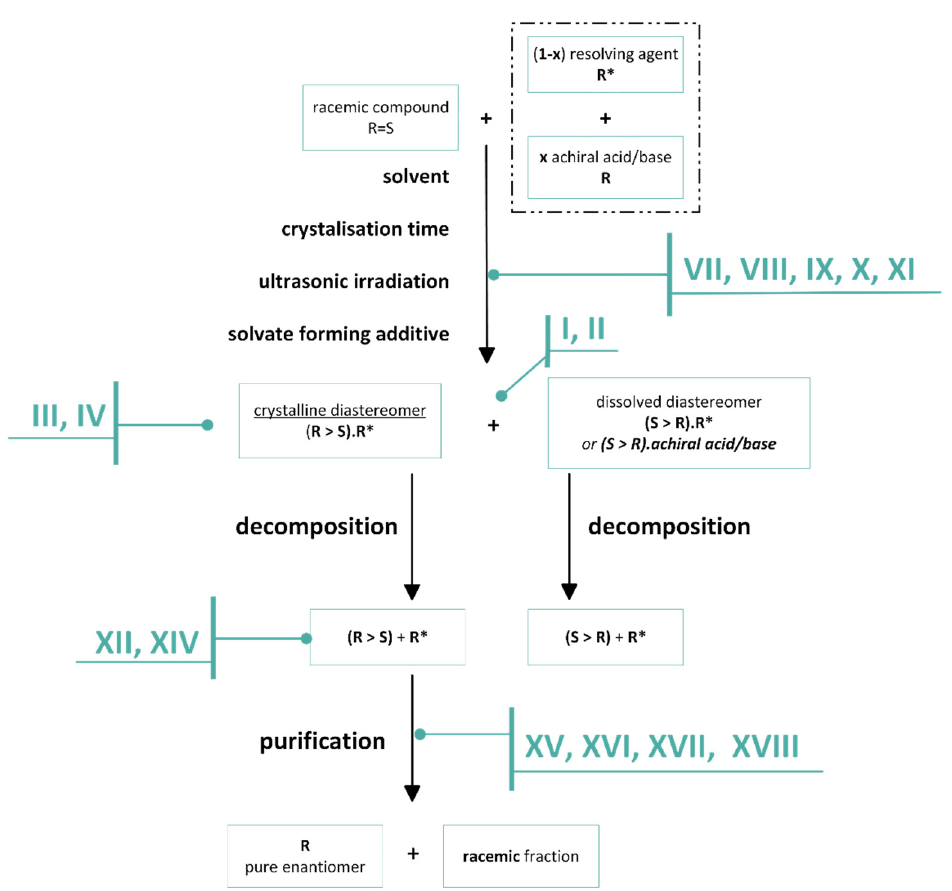
Figure 31. Schematic flow chart of a resolution, including the suggested protocol to be considered.